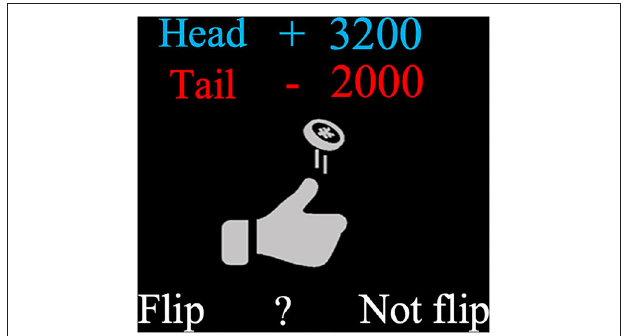
FIGURE 1 | Illustration of a typical trial. On each trial, subjects had to decide whether to accept or reject a coin-toss gamble that offered equal (50%) chances of gaining or losing different amounts of